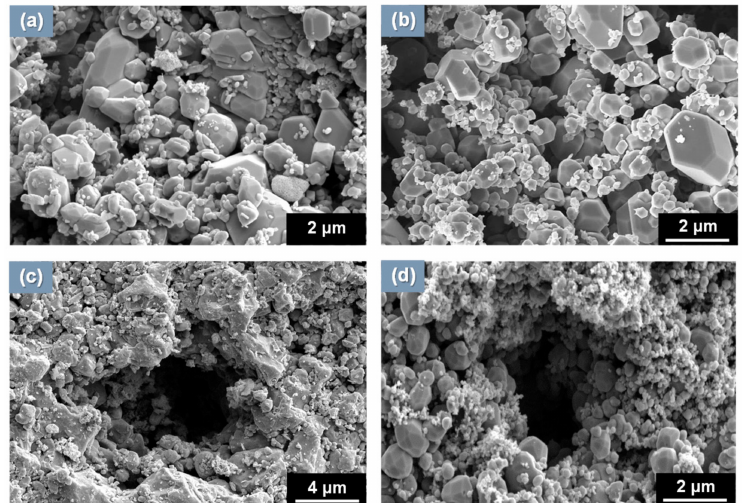
Figure 6. Scanning electron microscope (SEM) image of the outer surface of real SG tube deposits and simulated magnetite deposits: ( a ) particles of real deposits and ( b ) particles of simulated deposits, ( c ) pores of real deposits, and ( d ) pores of simulated